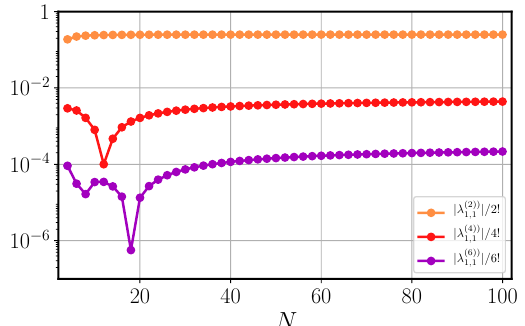
(cid:12) (cid:12) ( N, N/ 2) (cid:12) (cid:12) λ (2 k ) / (2 k )! for the first three non-vanishing cumulant super- (cid:12) (cid:12) 1 , 1